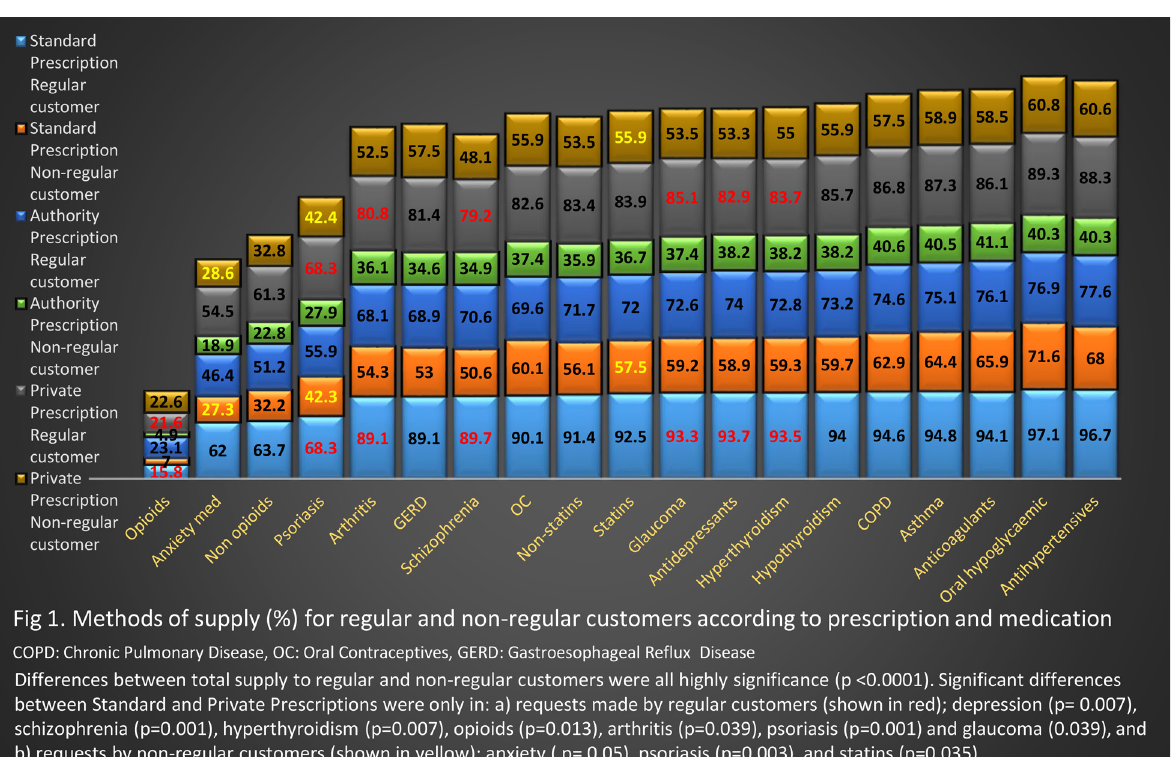
Fig 1. Comparison between the supply (%) for regular and non-regular customers according to prescription and medication types.